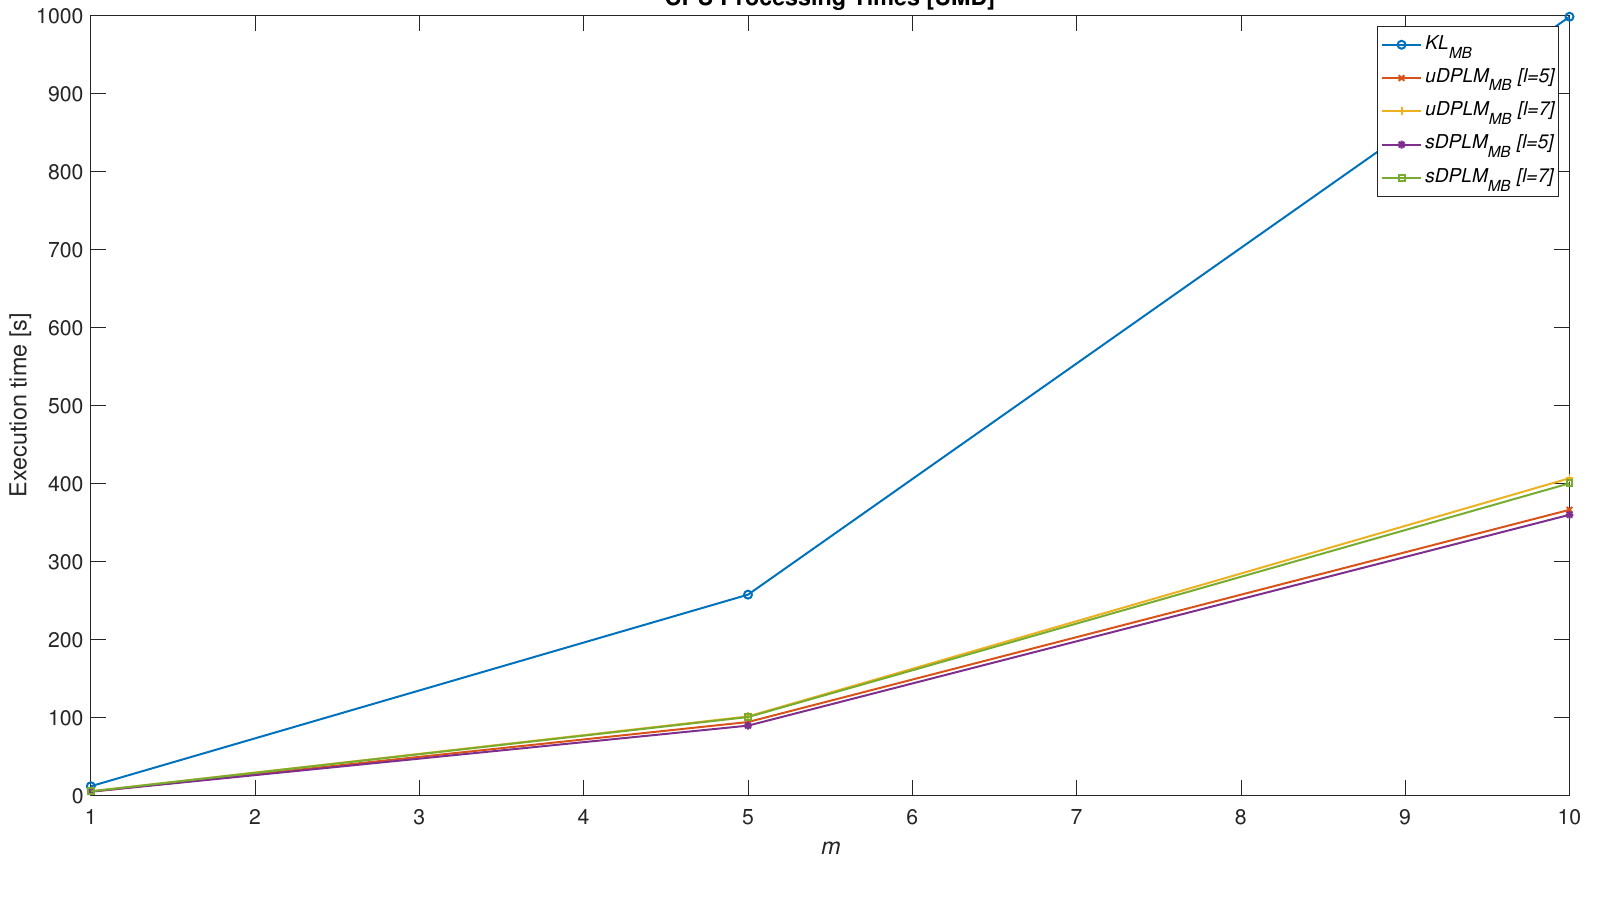
Figure 9. CPU processing times for the UMD database, DPLM MB vs. KL MB